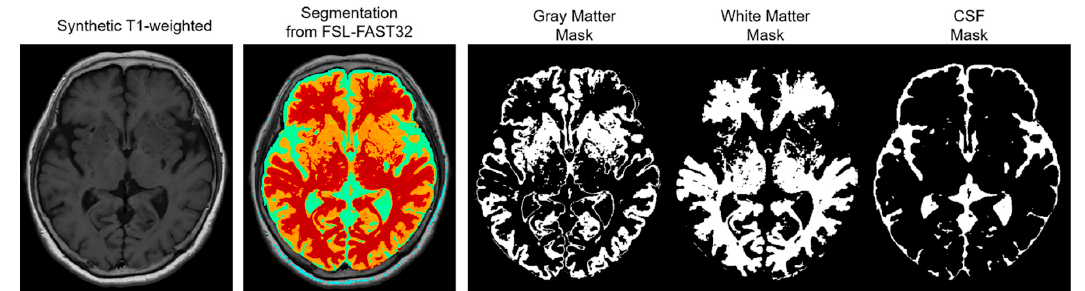
Figure 1. Illustration of the segmented regions during the region-wise evaluation. The region-wise evaluation is based on three automatically segmented regions: gray matter, white matter, and cerebrospinal fluid (CSF). The segmentations for the regions are retrieved via segmentation with FSL-FAST32 using the synthetic T1-weighted images.